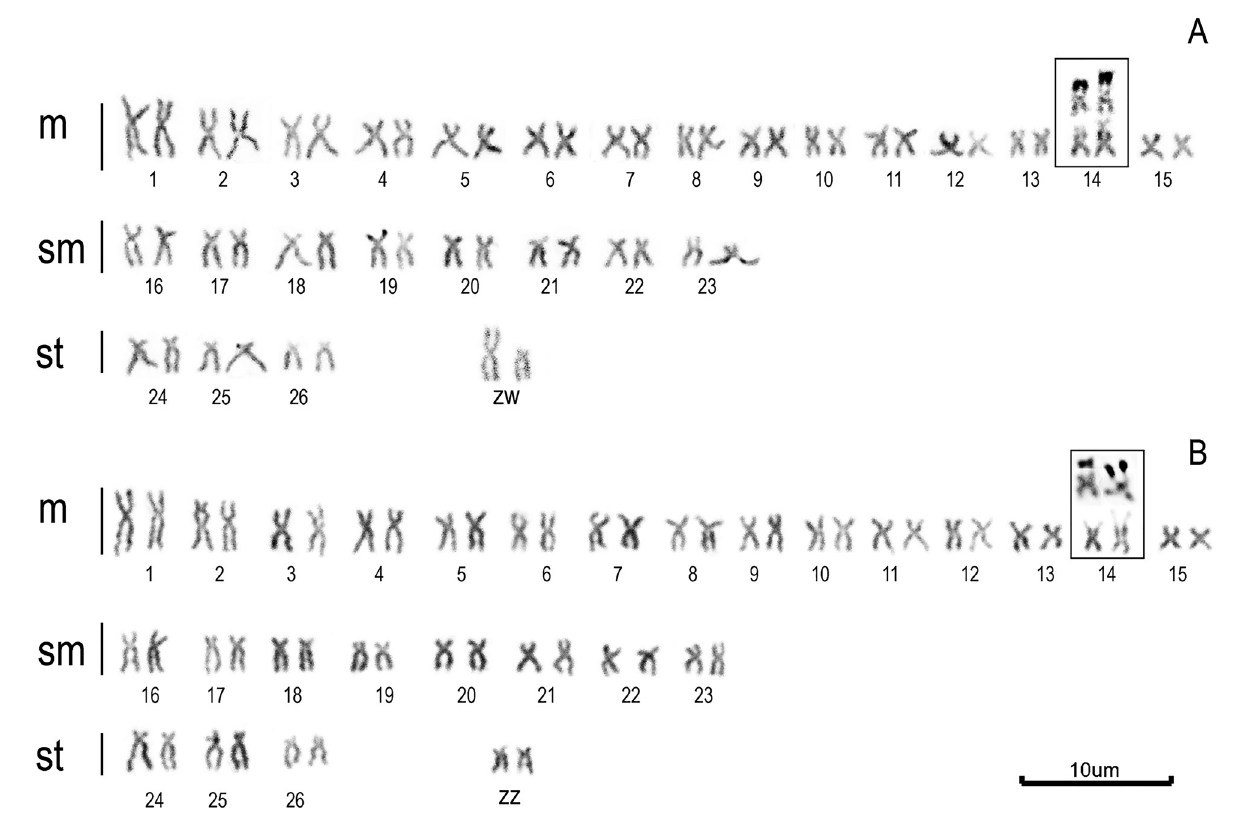
FIGURE 2 | Saccodon wagneri Giemsa karyotypes. A . Female; B . Male. Sex chromosomes are indicated. The NOR-carrying chromosomes, after silver staining, are boxed.